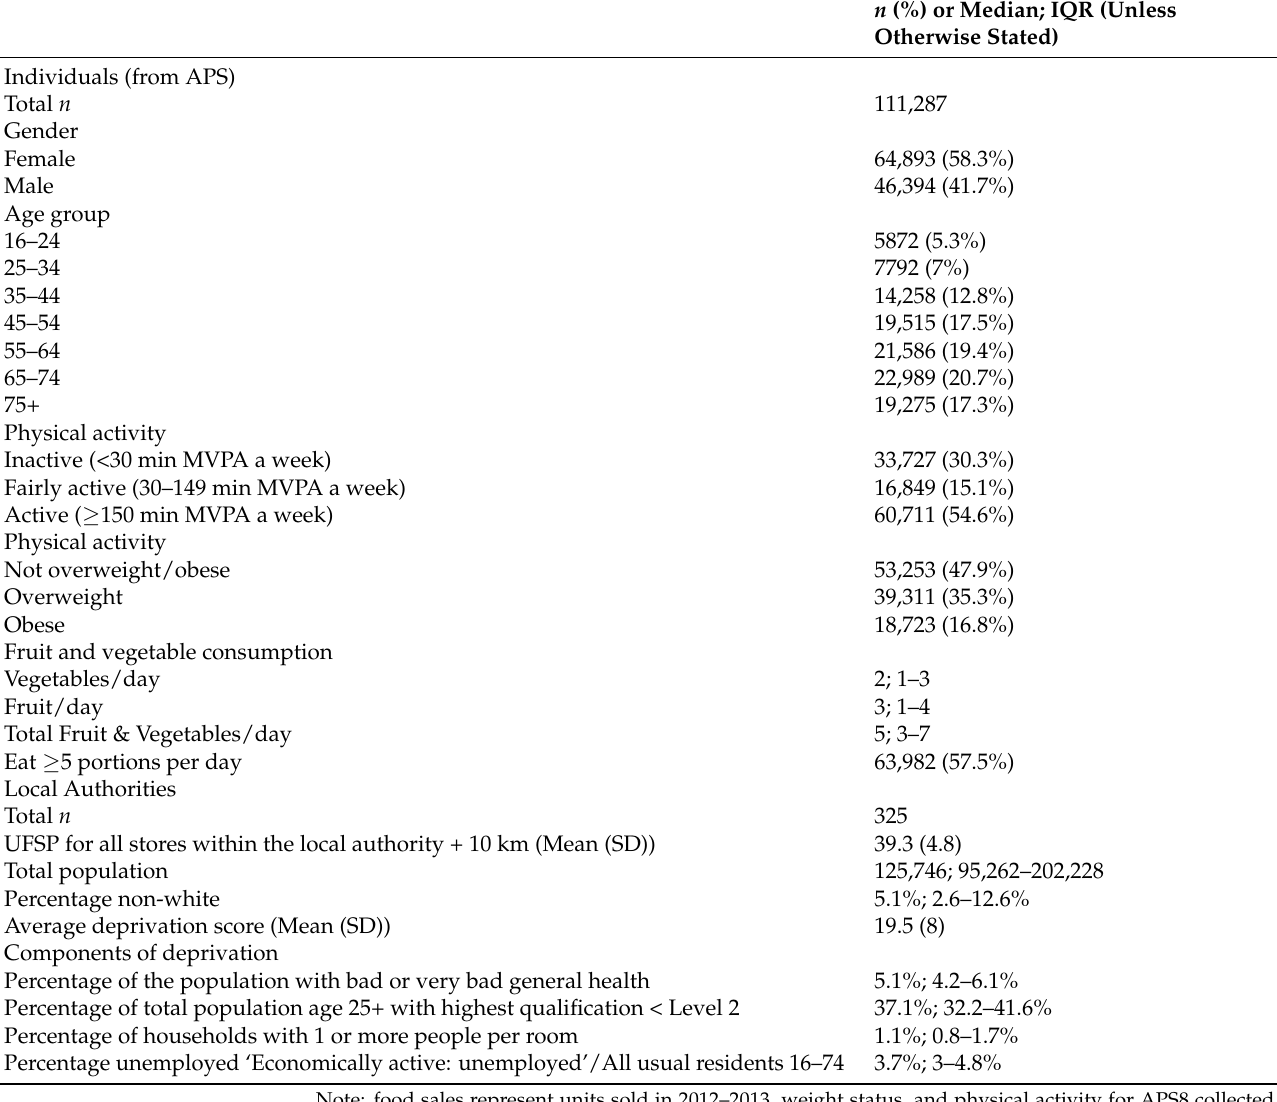
Table 1. Descriptive statistics of individual participants in the Active People Survey and English local authorities.